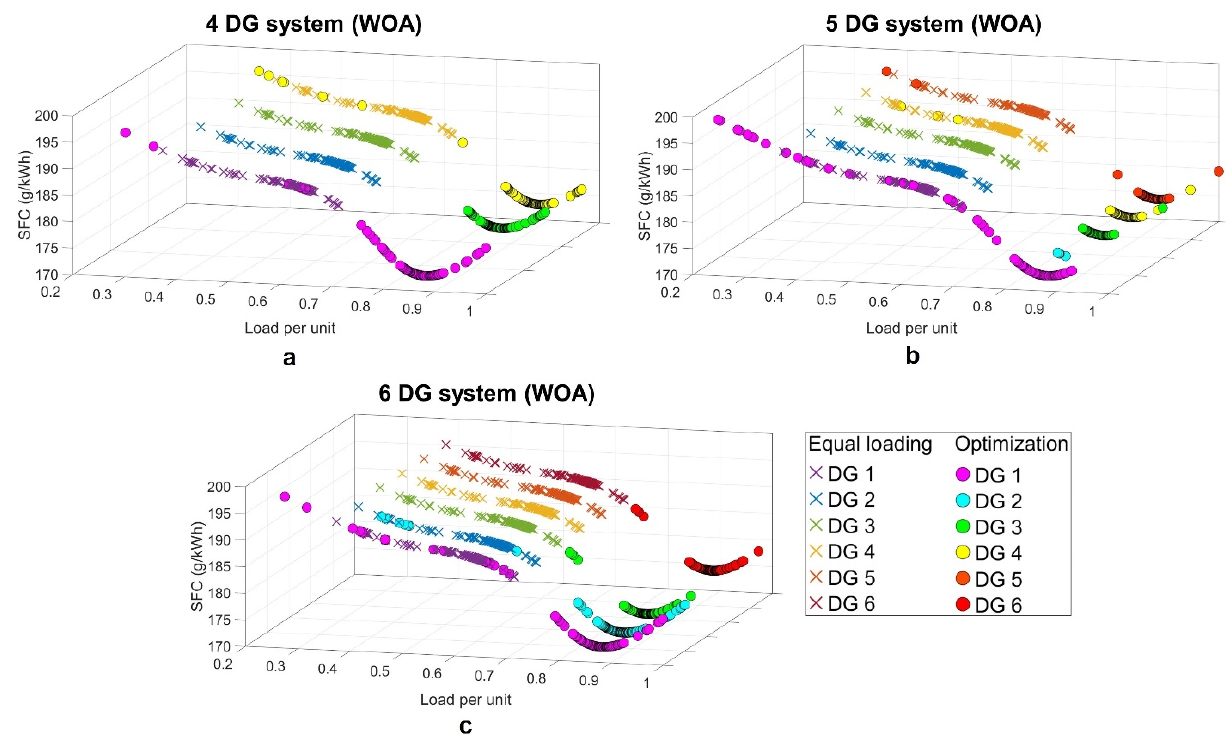
Figure 14. SFC results for the medium-speed profile by using WOA with: ( a ) 4-DG system ( b ) 5-DG system ( c ) 6-DG system.